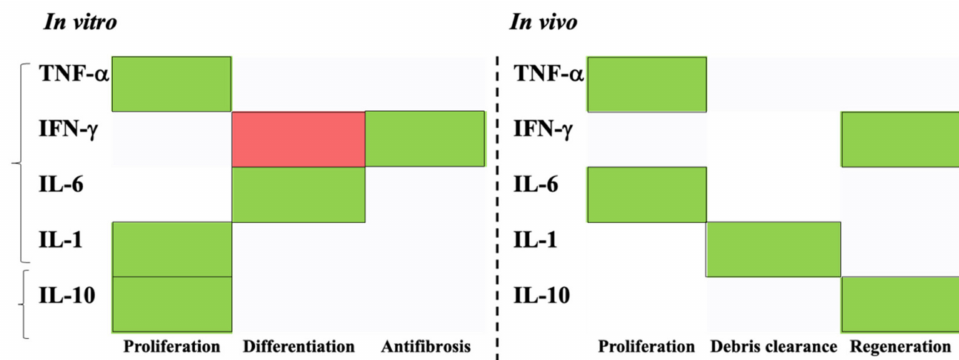
Figure 5. Schematic representation of cytokines contribution documented in both in vitro and in vivo studies (green box: promotion; red box: inhibition). Pro-inflammatory and anti-inflammatory cytokines showed an important contribution during skeletal muscle regeneration: in vitro, they mainly activated myoblasts proliferation and differentiation (except for INF- γ ); in vivo, cytokines expression, promoted tissue clearance and its regeneration. Abbreviations: TNF- α , Tumor Necrosis factor- α , IFN- γ , Interferon- γ , IL,